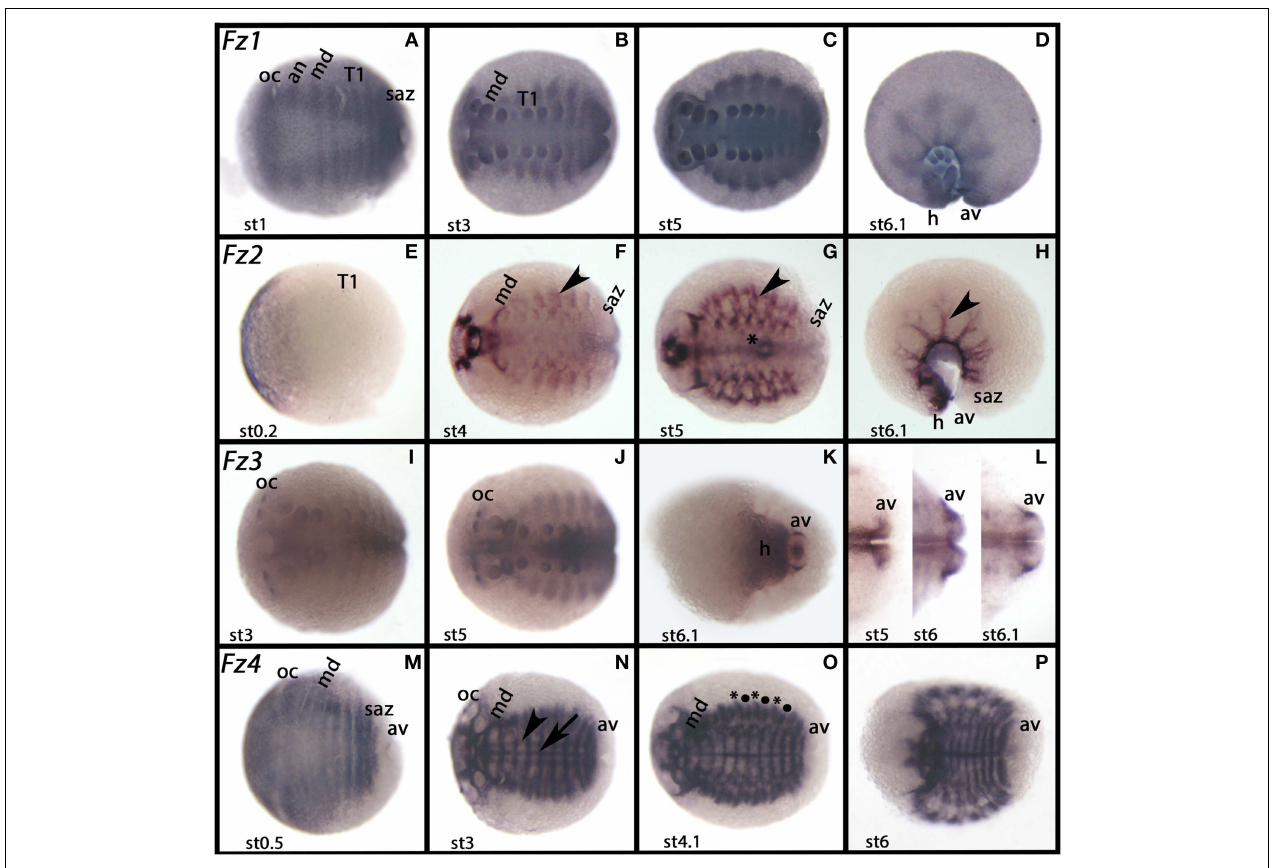
Asterisks and filled circles ( • ) in ( O) mark two domains of expression in every dorsal segmental unit of the trunk. The arrowhead in (F–H) marks dorsal expression. The asterisk in (G) marks expression in the midgut. an, antennal segment; av, anal valve; h, head; md, mandibular segment; oc, ocular region; saz, segment addition zone, st, stage; T, trunk